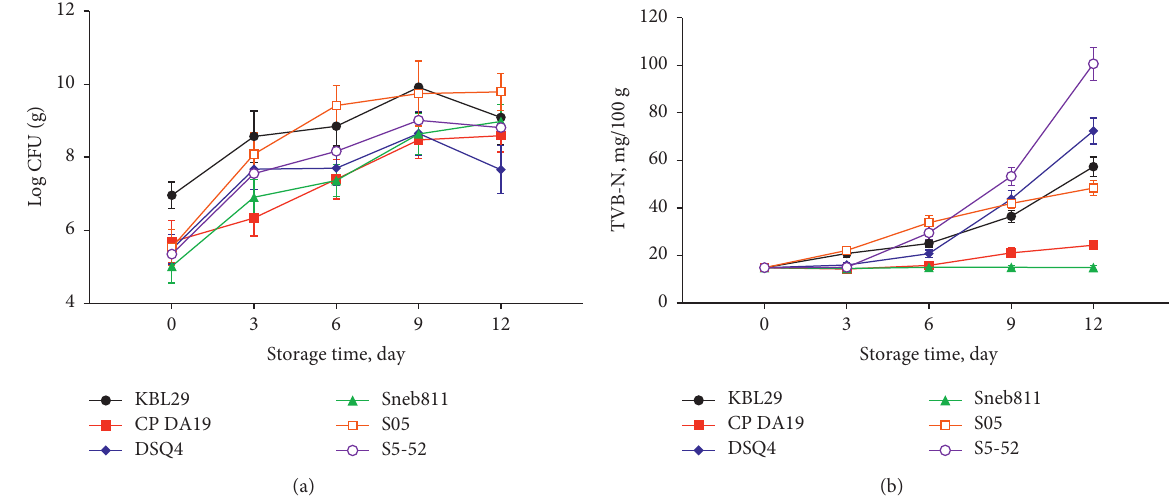
Figure 6: Changes of total bacterial colonies and TVB-N during the storage of rainbow trout juice incubated with 6 isolated spoilage strains. (a) Total bacterial colonies; (b)